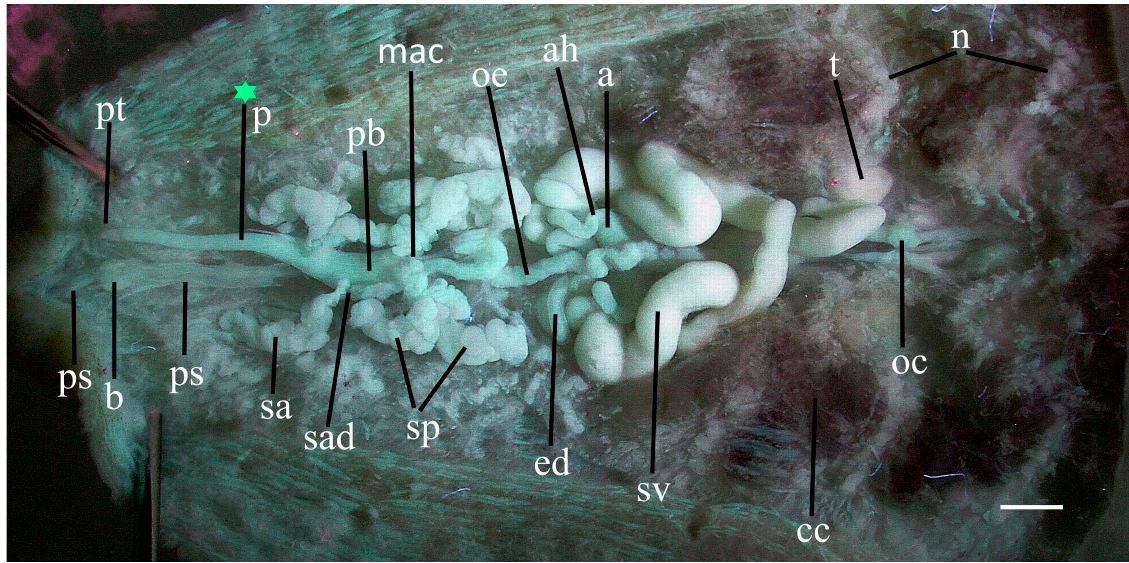
Figure 4. Dissection of a mature individual of P. parasitica from Outer Banks showing major organs in situ (PP ‐ 1, 36.5 mm). Abbreviations: a, atrium; ah, atrial horn; b, brain; cc, crop caecum with blood; ed, ejaculatory duct; mac, median annectant salivary cells; n, nephridia; oc, common ovisac; oe, oe